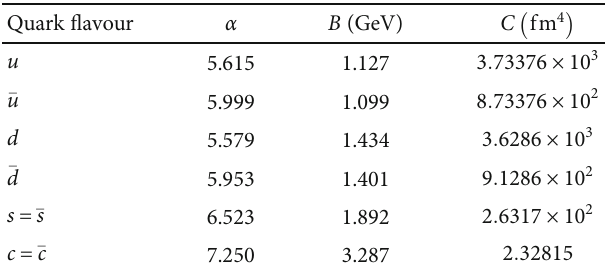
ffiffiffiffiffiffiffiffi p = 2 : 76TeV s NN